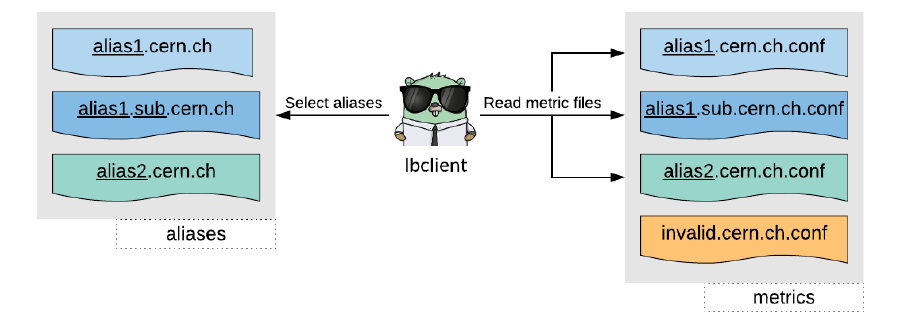
Figure 2. Configuration overview of the standalone client (lbclient) within a host